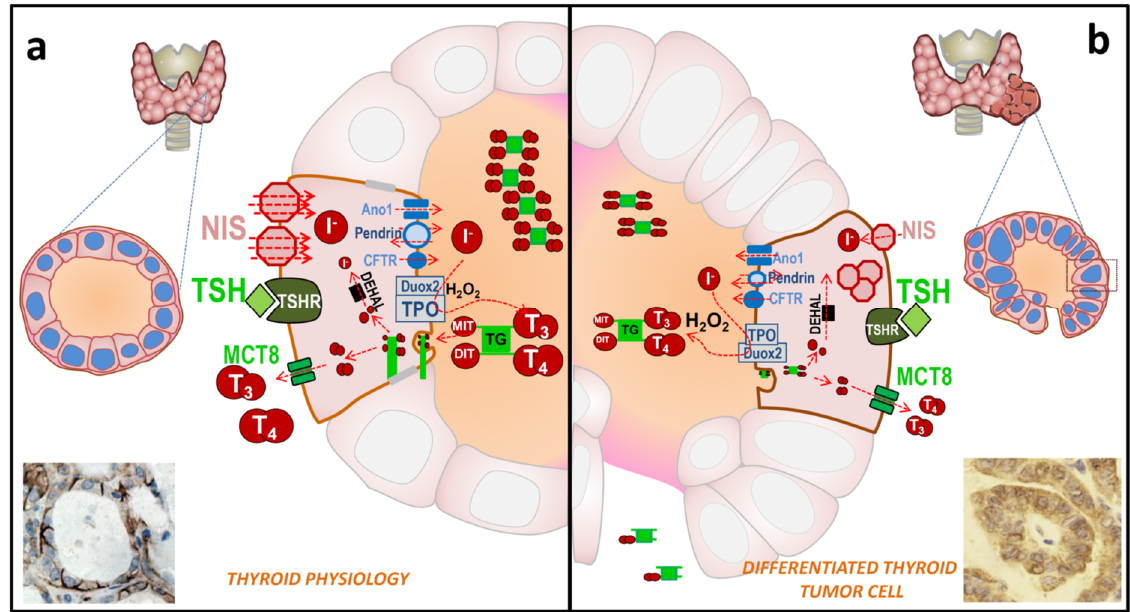
Figure 2. Schematic representation of the biosynthesis of thyroid hormones (TH) in normal and differentiated thyroid cancer (DTC) thyroid tissue. ( a ) Physiology of a thyroid cell. The thyroid follicle is made up of epithelial cells. The basolateral membrane is in contact with the blood stream, where iodide from the diet, or iodide recycled from dehalogenation in peripheral tissues, arrives. Iodide is transported against its concentration gradient by the plasma membrane protein sodium/iodide symporter (NIS) (red diamonds) thanks to the sodium gradient provided by the sodium and potassium- ATPase. NIS can concentrate more than 40–100 times the concentration of iodide in the blood. The iodide goes to the apical membrane side of the cell, essentially by concentration gradient, and is then transported to the colloid by means of different transporters (Anoctamin 1 (Ano1/TMEM16A), Pendrin and cystic fibrosis transmembrane conductance regulator (CFTR) located in the apical membrane of the thyroid follicle cell. The Duox2 enzyme generates H 2 O 2 , which is used by TPO to oxidize iodide in the TG molecule (organification), forming iodotyrosine residues (MIT and DIT). TPO itself couples two residues of MIT and/or DIT to synthetize the thyroid hormones (TH) T3 and T4, although they are still bound to TG. Iodinated TG (TG-I), as iodotyrosine or iodotyronine residues, accumulates in the colloid until there is further need for TH. When TH is required, TG is internalized into the cytoplasm, proteolyzed, and the iodinated residues are released. The iodine from the MIT and DIT residues is recycled by the Iodotyrosine dehalogenase 1 (DEHAL) enzyme. T3 and T4 are transported to the bloodstream by the MCT8 membrane protein. TSH, through its receptor on the basolateral membrane (TSH-R), is the master hormone that regulates most of the indicated processes at different levels, in addition to cell proliferation and growth. Immunohistochemistry shows the expression of NIS in the basolateral membrane of a non-anaplastic thyroid. ( b ) Thyroid tumor cell physiology in differentiated thyroid cancer (DTC). In tumor cells, the follicular structure is not always well preserved, and TG can be released into the bloodstream. The expression of key TH synthesis proteins is reduced (TSH-R, NIS, TPO, and pendrin) or delocalized from the place where they are functional, which prevents correct TH synthesis. Furthermore, Duox2 is usually not diminished, so the production of H 2 O 2 does not decrease, which may lead to an increase in ROS that alter the synthesis and degradation of cell mechanisms. Immunohistochemistry shows the expression of NIS localized both at the basolateral membrane and in the cytoplasm in DTC